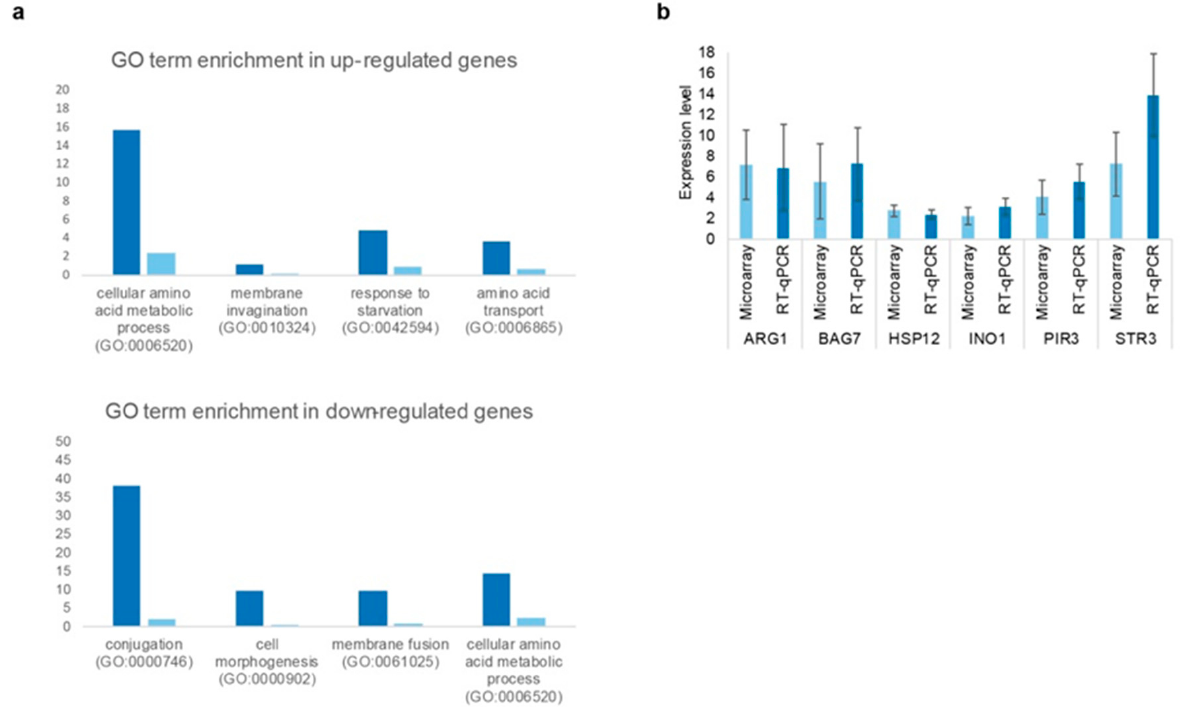
Figure 7. Genome-wide expression profile of wild-type cells following neomycin treatment. ( a ) Gene Ontology term enrichment within the genes up- or downregulated upon neomycin exposure. The graph indicates the percentage of genes clustered into the indicated GO terms for the differentially expressed genes upon neomycin treatment (dark blue) compared to that of the overall genome (light blue). According to a χ 2 test, only p -values ≤ 0.05 were considered. ( b ) Comparison of the neomycin transcriptional induction determined by DNA microarrays and RT-qPCR. The graphic shows the level of induction of six genes selected to confirm by RT-qPCR (dark blue) the initial values obtained in the DNA microarray assays (light blue). The columns represent the mean, and the error bars indicate the standard deviation from three independent experiments.